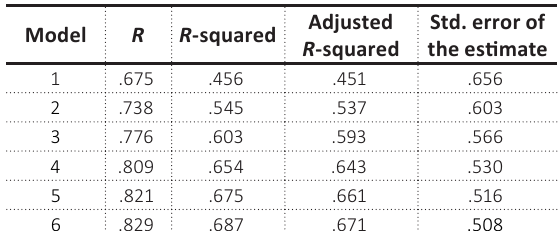
Table 3. Regression model summary